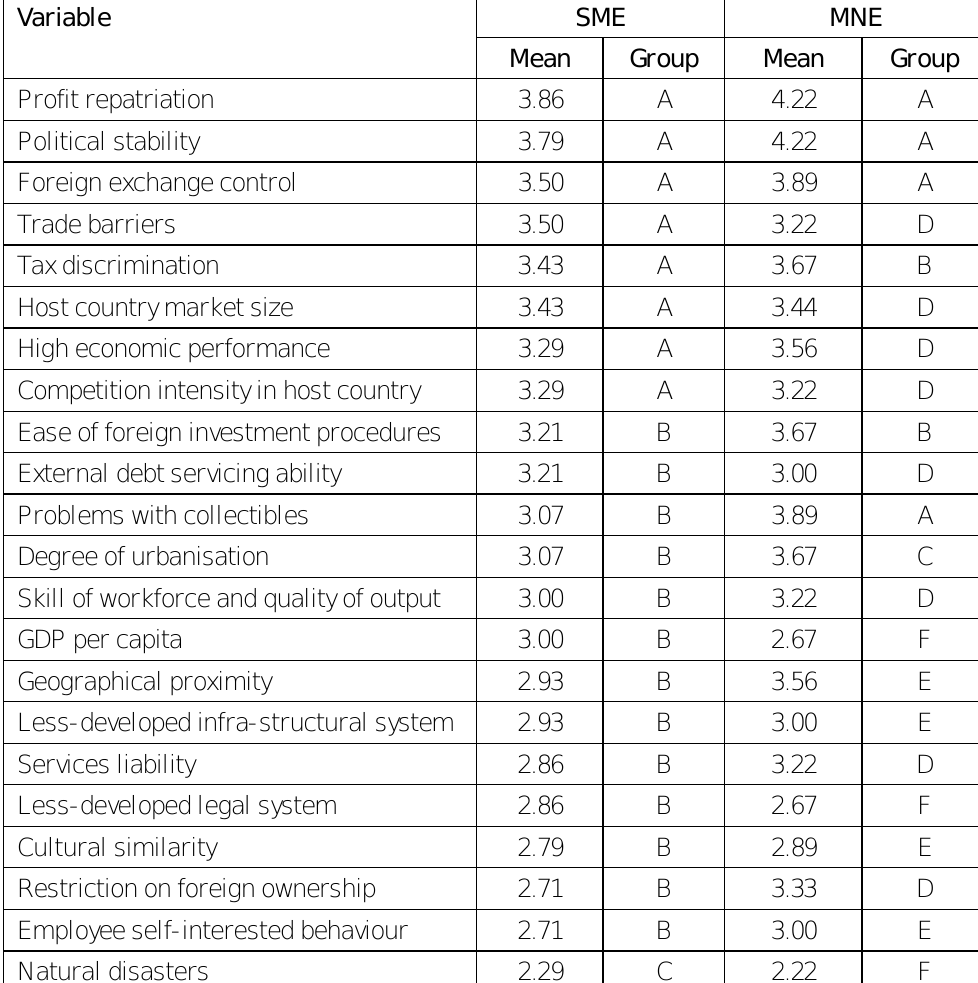
Table 2: Host country factors analysis by descending means and sub-groups